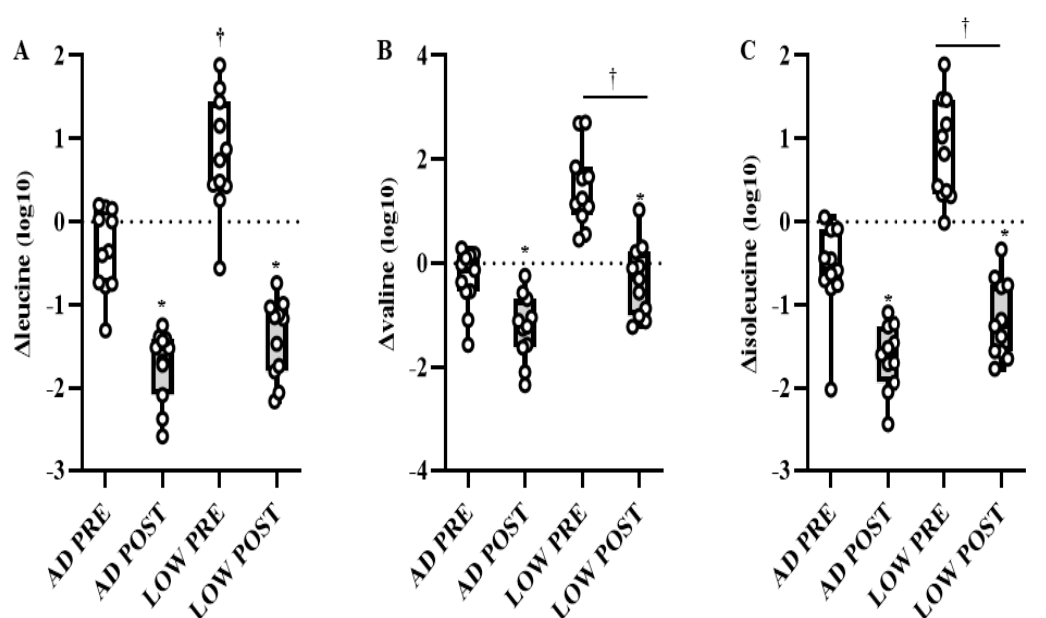
Figure 3. Mean ± SD of change in leucine ( A ), valine ( B ), and isolecuine ( C ) from BASELINE to PRE and POST aerobic exercise following 24 h of refeeding to elicit adequate (AD) or low (LOW) glycogen stores. n = 11, * Different from PRE; p < 0.05, Q < 0.10. † Different from AD ; p < 0.05, Q < 0.10 .